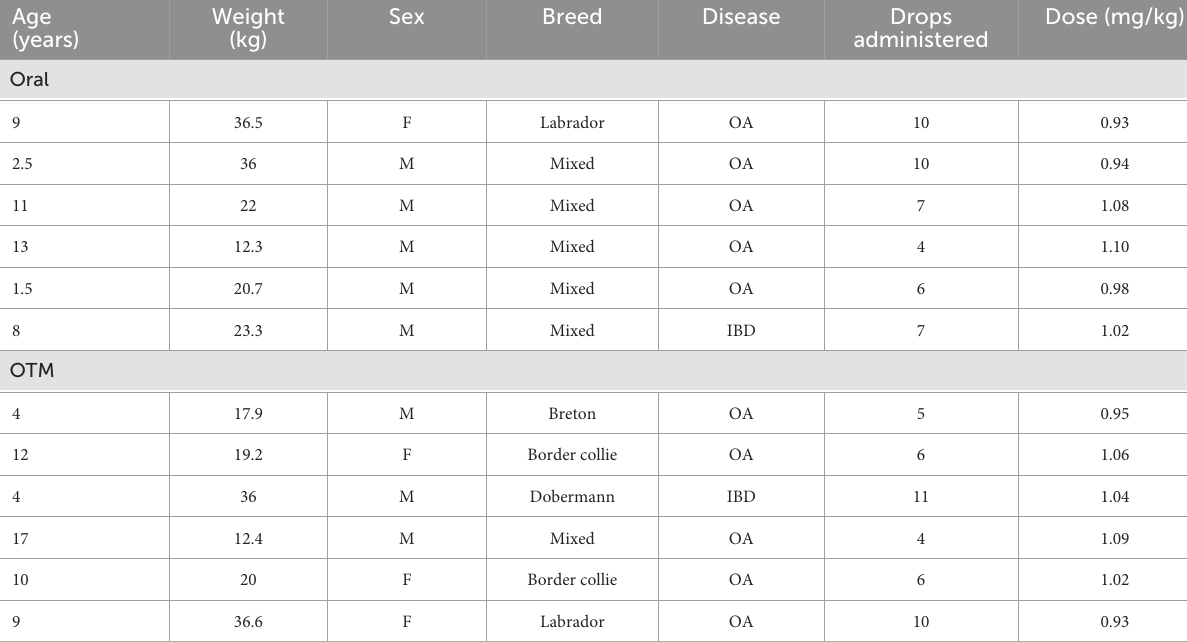
Sex Breed Disease Drops